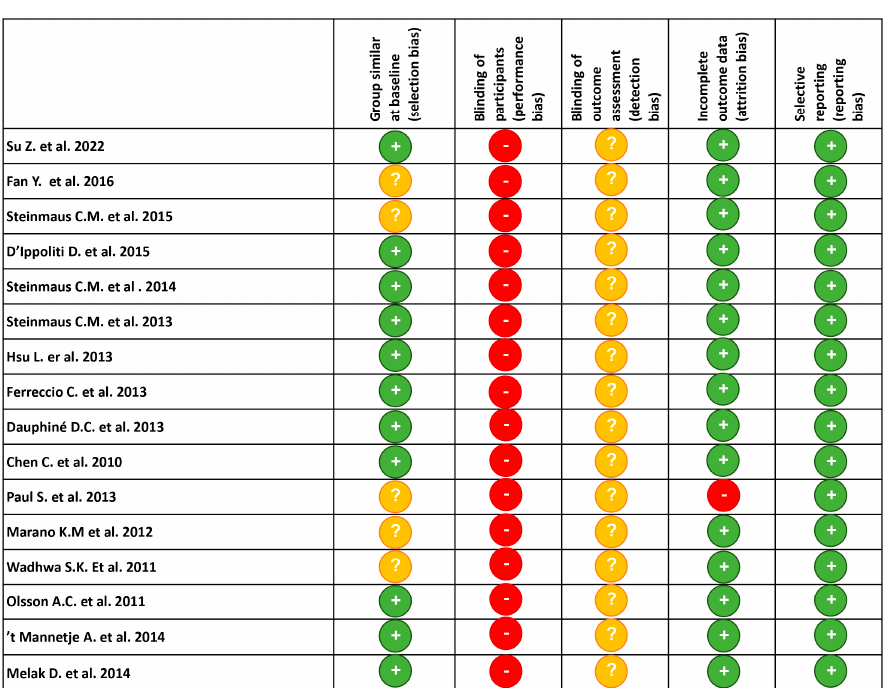
Figure 2. Assessment risk of bias [29–44]. Green circles with “+” sign indicate low risk, yellow circles with “?” sign indicate unclear risk, red circles with “-“ sign indicate high risk.